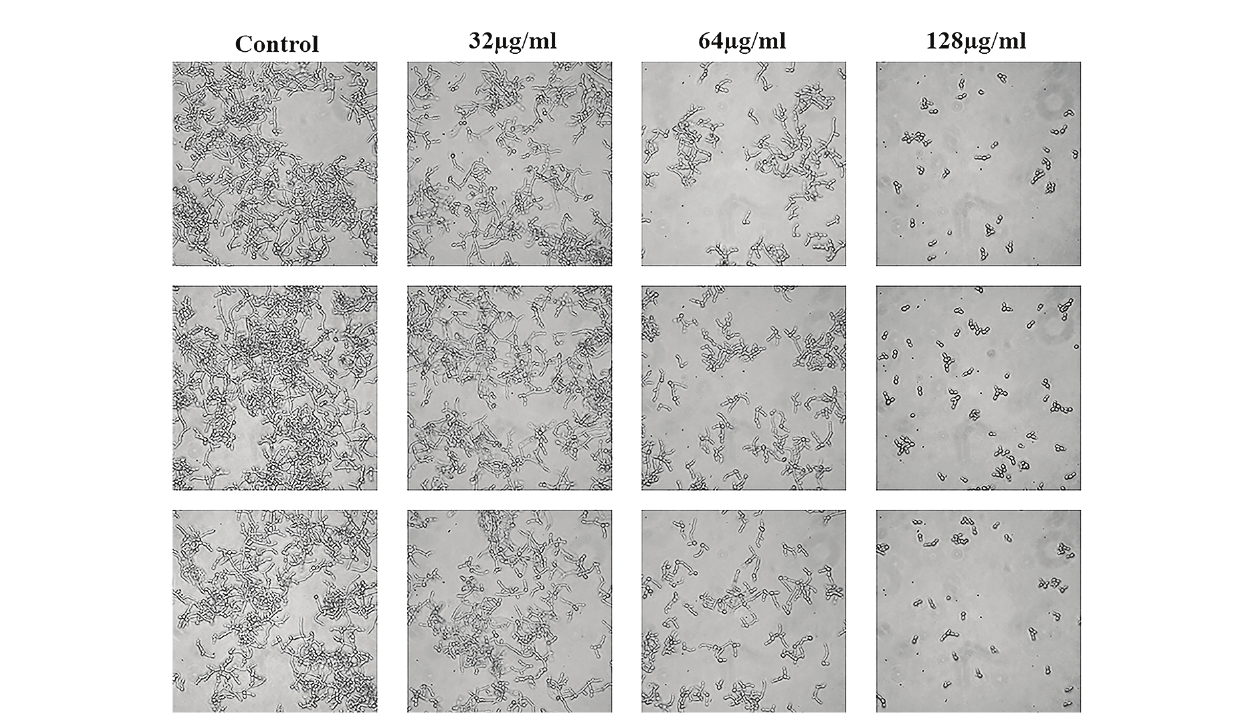
FIGURE 4 | Effect of NBP on C. albicans hyphal growth induced by RPMI 1640 medium. NBP was diluted in hyphae-inducing media, RPMI 1640 medium, at a final concentration of 0, 32, 64, and 128 μg/ml, respectively. The cellular morphology was photographed after incubation at 37 ° C for 4 h. The photographs were collected from three independent